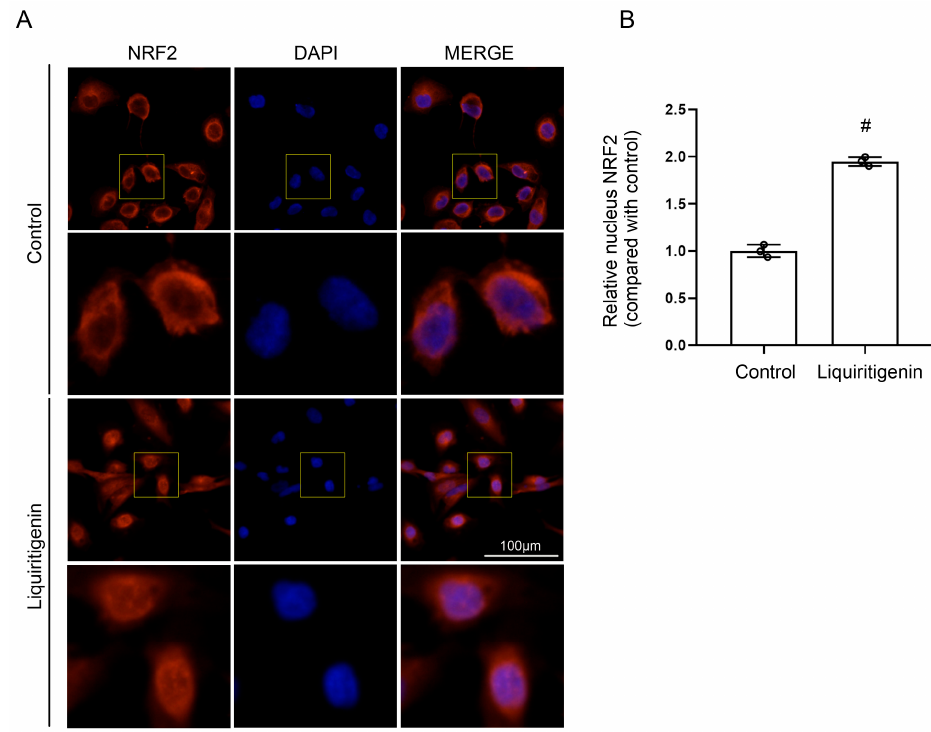
Figure 5. The effect of liquiritigenin on the nuclear translocation of NRF2. ( A ) Subcellular location of NRF2 determined by immunofluorescence microscopy in live cultured renal tubule epithelial cells with liquiritigenin treatment. Nuclei were revealed using 4 ′ ,6-diamidino-2-phenylindole staining (DAPI). ( B ) Quantification of nucleus NRF2 fluorescence density. The results were nor- malized to the ratio of the nucleus NRF2 of vehicle-control. # p < 0.05 vs. the vehicle-control group. Data were obtained from three independent biological replicates.